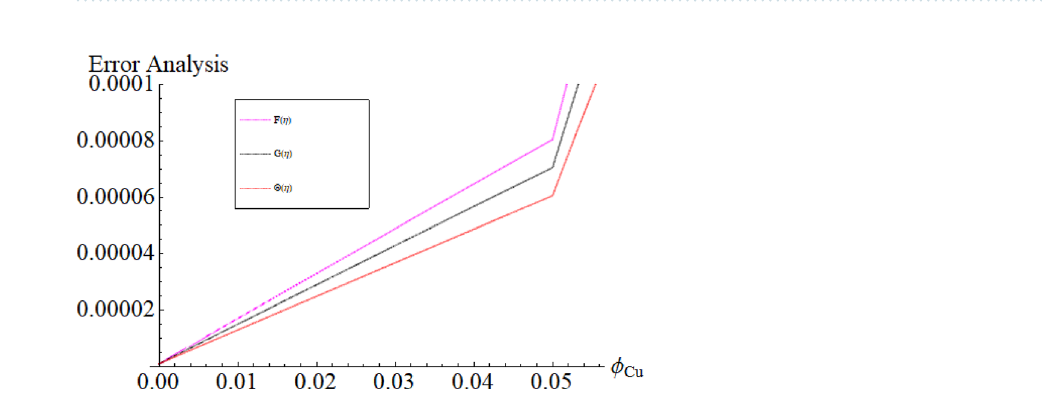
Figure 22. Impression of the parameter